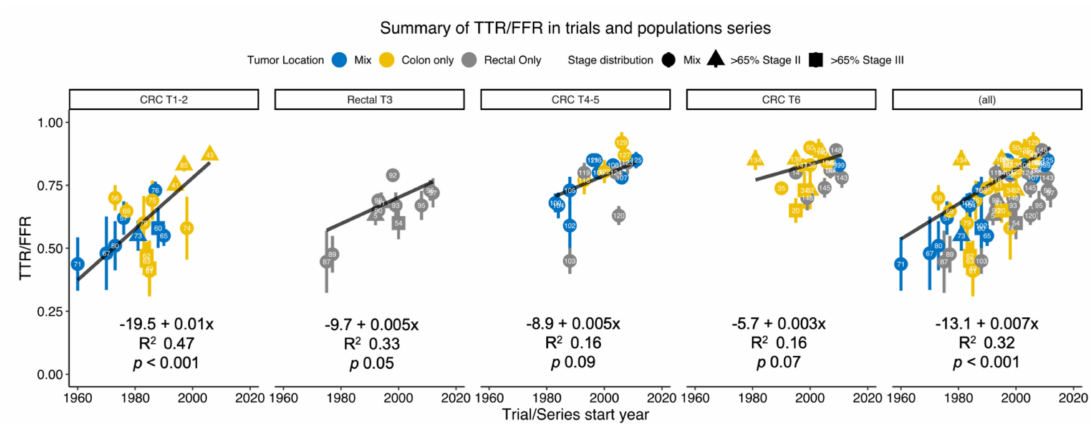
Figure 2. Time to recurrence (TTR) or freedom from (crude) recurrence (FFR) in surgically operated nonmetastatic colorectal cancer patients according to when the first patient was operated. Improvements with time were seen when all trials were included (right panel) and in the di ff erent types of trials as presented in the six Tables. The numbers in each filled point refer to the reference number as provided in the tables and reference list. Individual points are coloured by distribution of colon vs rectal cancer and shapes represents stage mix in each study. Linear regression for the trend, weighted by number of cases in the studies, are presented for each panel and for the total with the equation, R 2 and p -value presented for each panel. In the left panel (CRC T1–2), TTR / FFR are from the untreated control